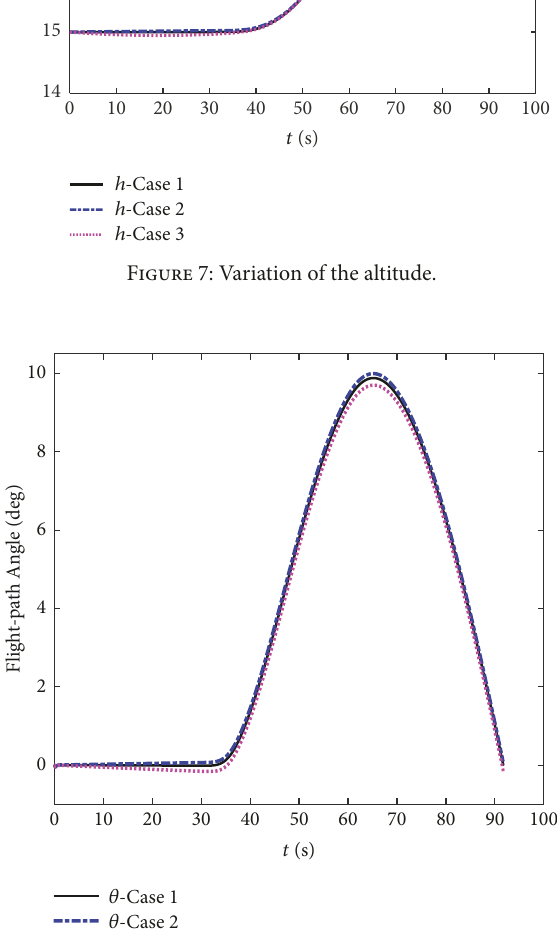
Figure 6: The reconstruction error of angle of attack.